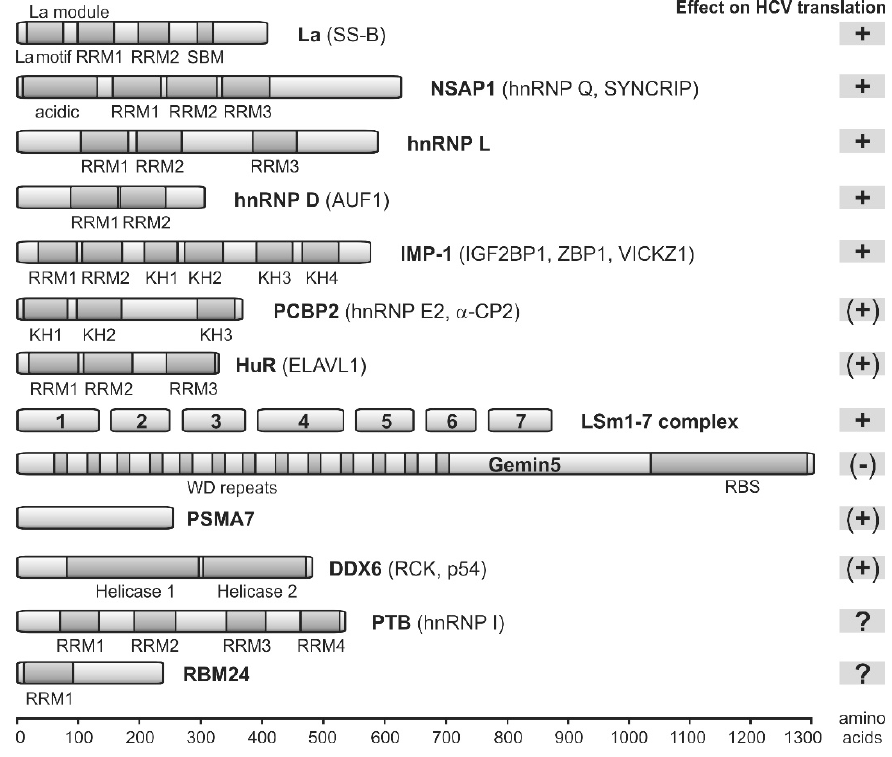
Figure 6. IRES trans-acting factors (ITAFs) that modulate HCV IRES activity. Important functional domains are shown in dark grey. In most cases, these domains are RNA-binding domains, similar to the RNA-recognition motif domain (RRM) [194] or the K-homology (KH) domains of hnRNP proteins [195].